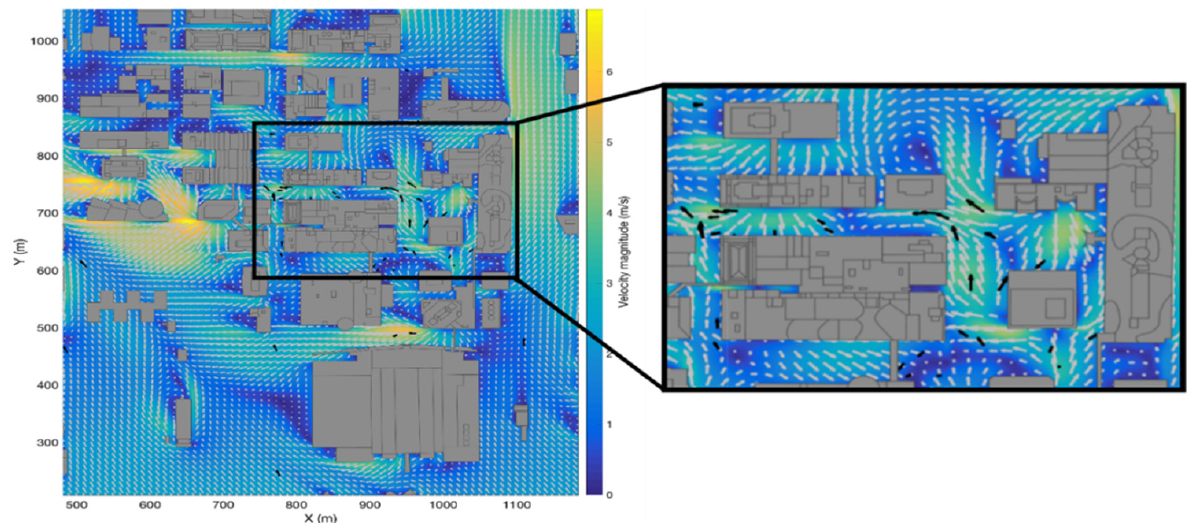
Figure 8. Velocity vectors from Aeolus (gray arrows) and observations (black arrows) for IOP 8 trial 2 during the Joint Urban 2003 field experiment. The simulation shows the horizontal slice (xy plane) at 2 m AGL. The zoomed-in area highlights urban effects that are predicted well by Aeolus.